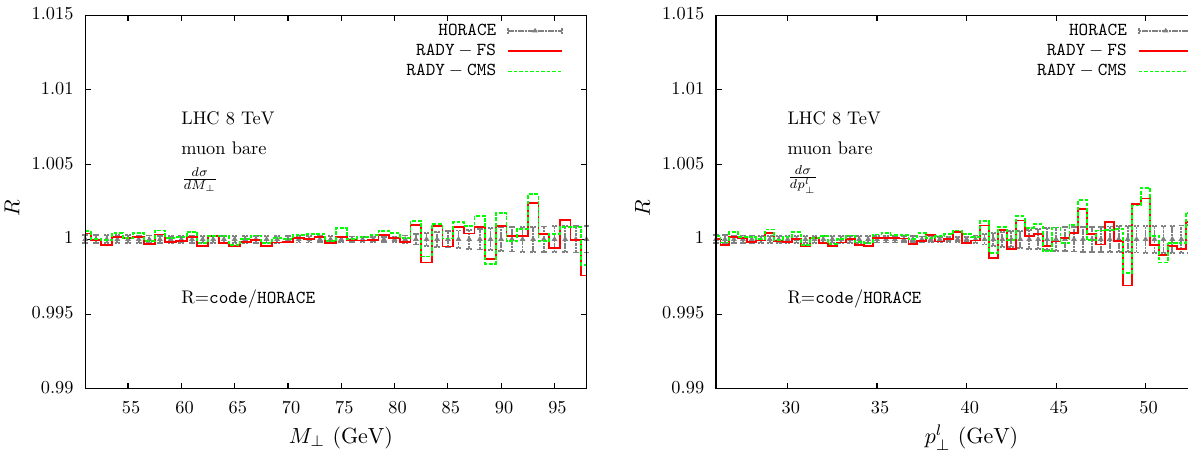
Fig. 26 Comparison of RADY NLO EW predictions when using dif- ferent schemes for treating the W resonance. The plots show the trans- verse mass and momentum distribution of the final-state charged lepton